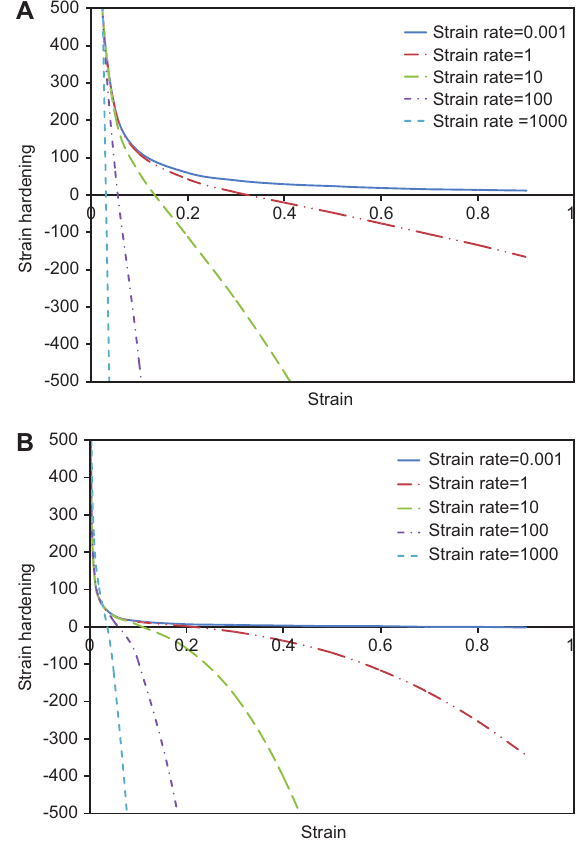
Figure 12 Change of strain hardening vs. strain of CR-1018 steel for different temperatures at strain rates of (A) 0.001/s and (B) 1000/s.